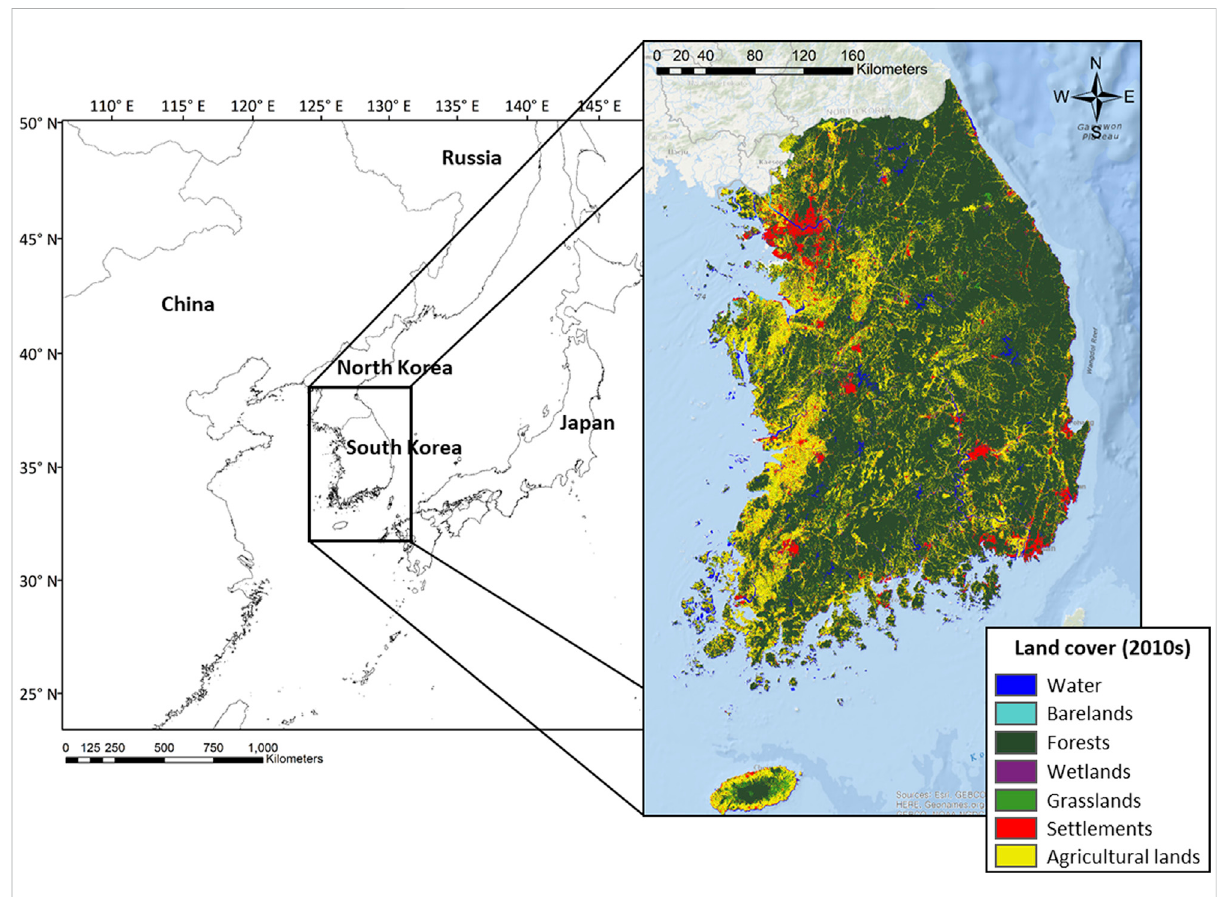
FIGURE 1 Geographical location of study area and land